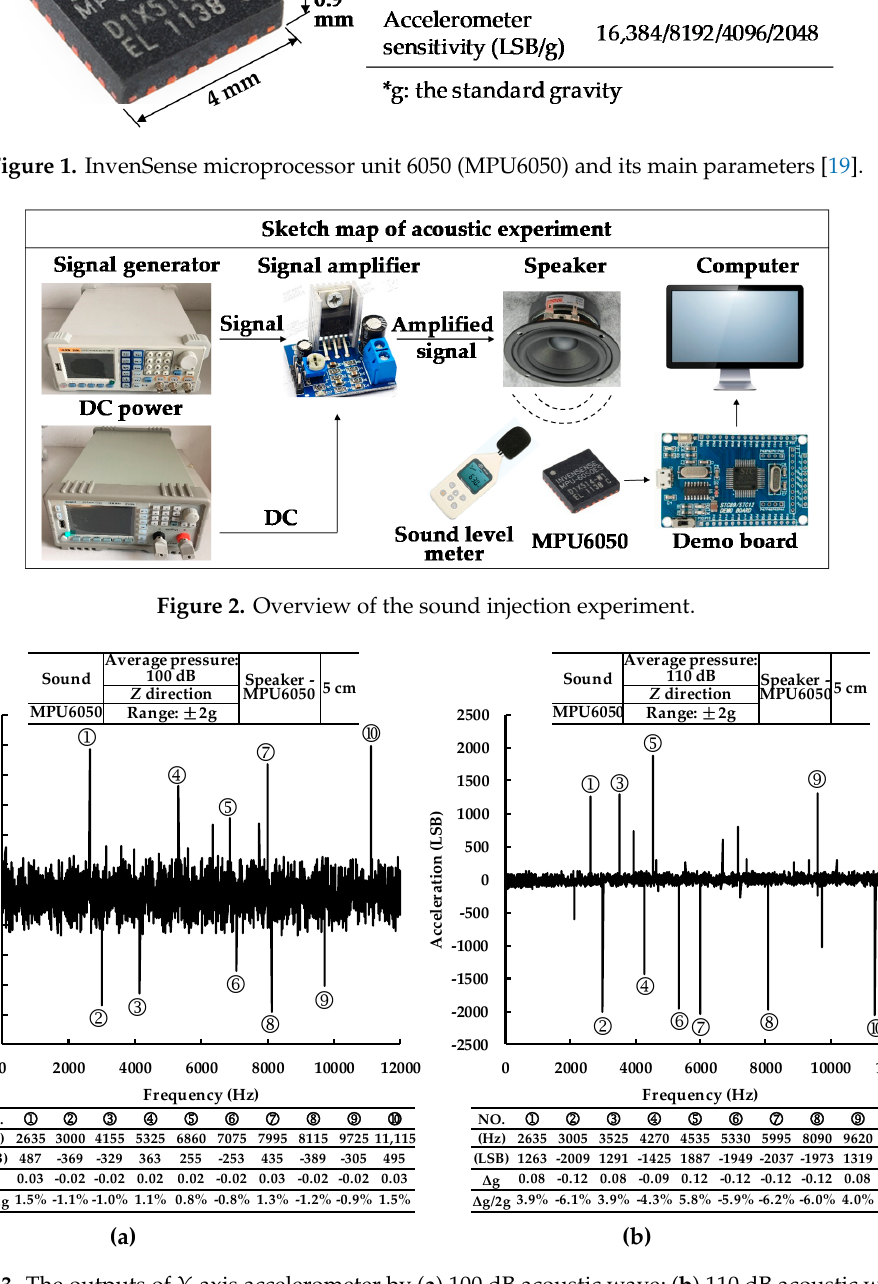
Figure 3. The outputs of Y -axis accelerometer by ( a ) 100 dB acoustic wave; ( b ) 110 dB acoustic wave.